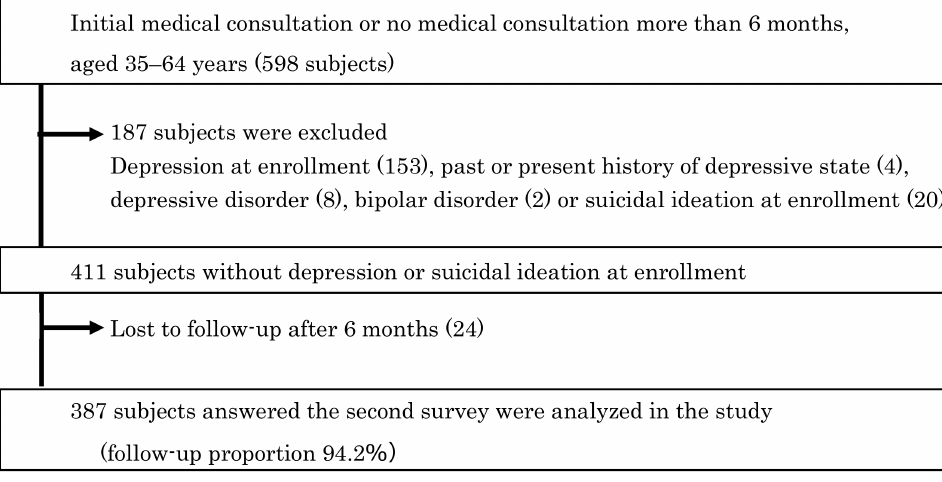
Figure 1. Flow chart of enrollment of the study